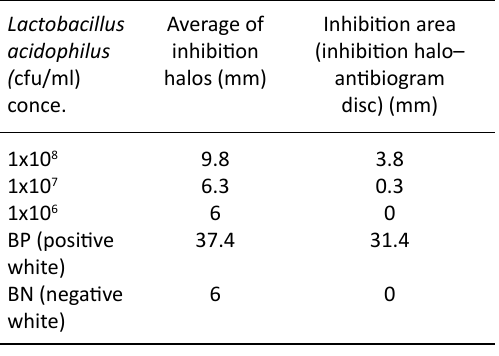
Table 3. Cosmetic formulas (lotions) with L. acidophilus